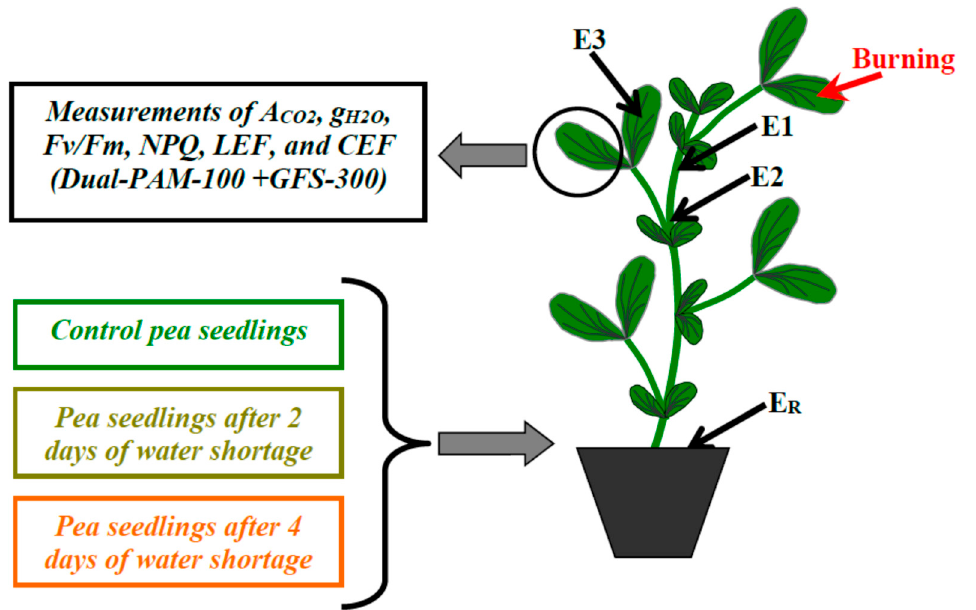
Figure 10. Scheme of measurements of surface electrical potentials, photosynthetic parameters, and leaf stomatal conductance in pea seedlings under control conditions and after 2 and 4 days of soil water shortage. A CO2 is the photosynthetic CO 2 assimilation; g H2O is the leaf stomatal conductance; Fv/Fm is the maximal quantum yield of photosystem II; NPQ is the non-photochemical quenching; LEF is the photosynthetic linear electron flow; and CEF is the cyclic electron flow around photosystem I. E1, E2, and E3 are the measuring electrodes; E R is the reference electrode. The water shortage was initiated by termination of irrigation of the plants. The red arrow marks the local burning of the first mature leaf (flame, 2–3 s).